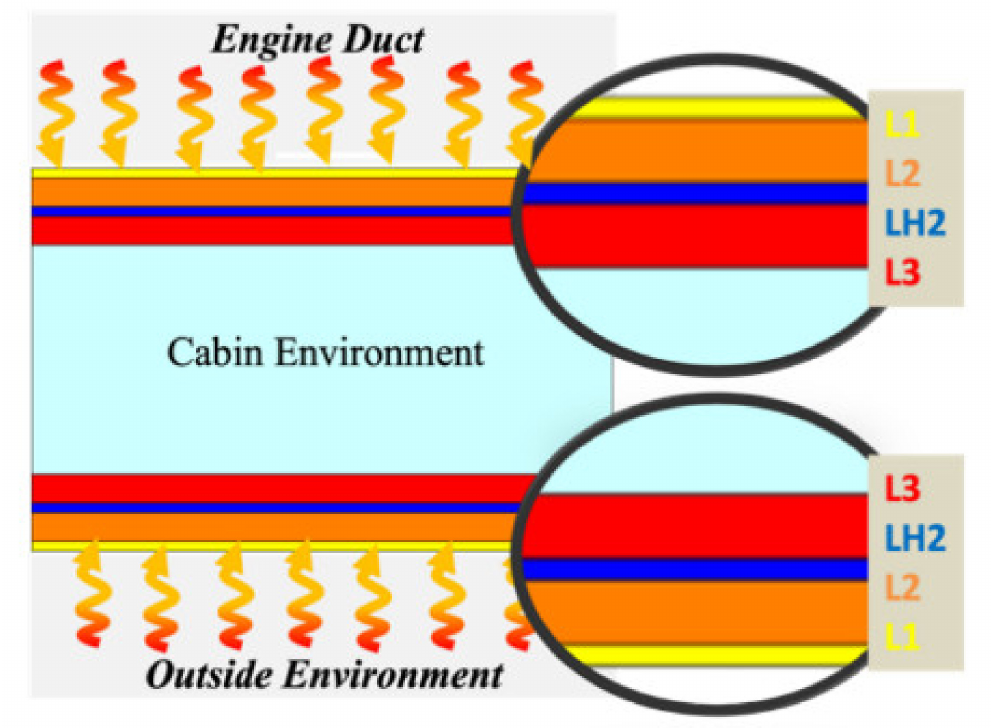
Figure 14. Cross-section of the cabin